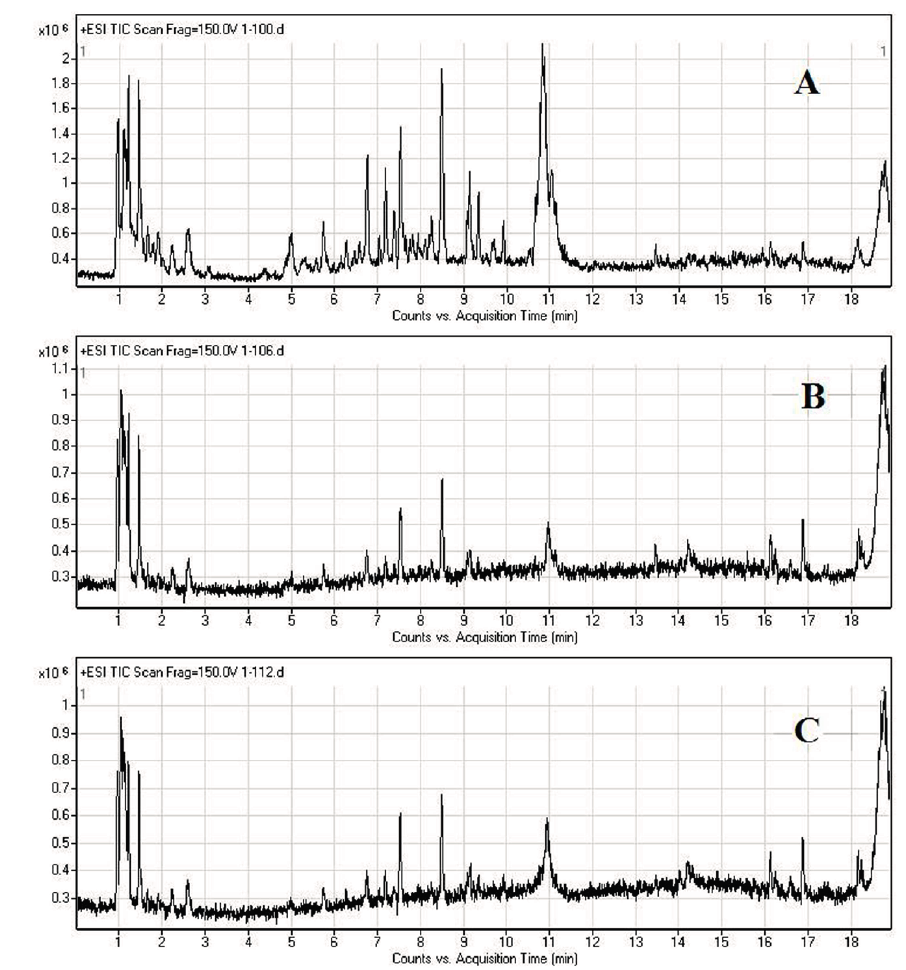
Figure 2. Total ion currents of mouse urine samples obtained from control group ( A ); FA 4 mg/m 3 group ( B ); and FA 8 mg/m 3 group ( C ) after 7 days of FA exposure as determined using LC/MS (positive mode).